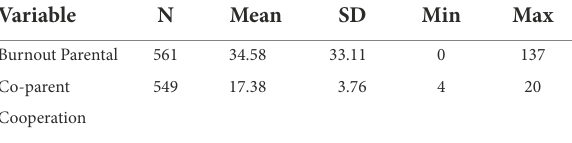
TABLE 2 Descriptive of PB and COPs for objective